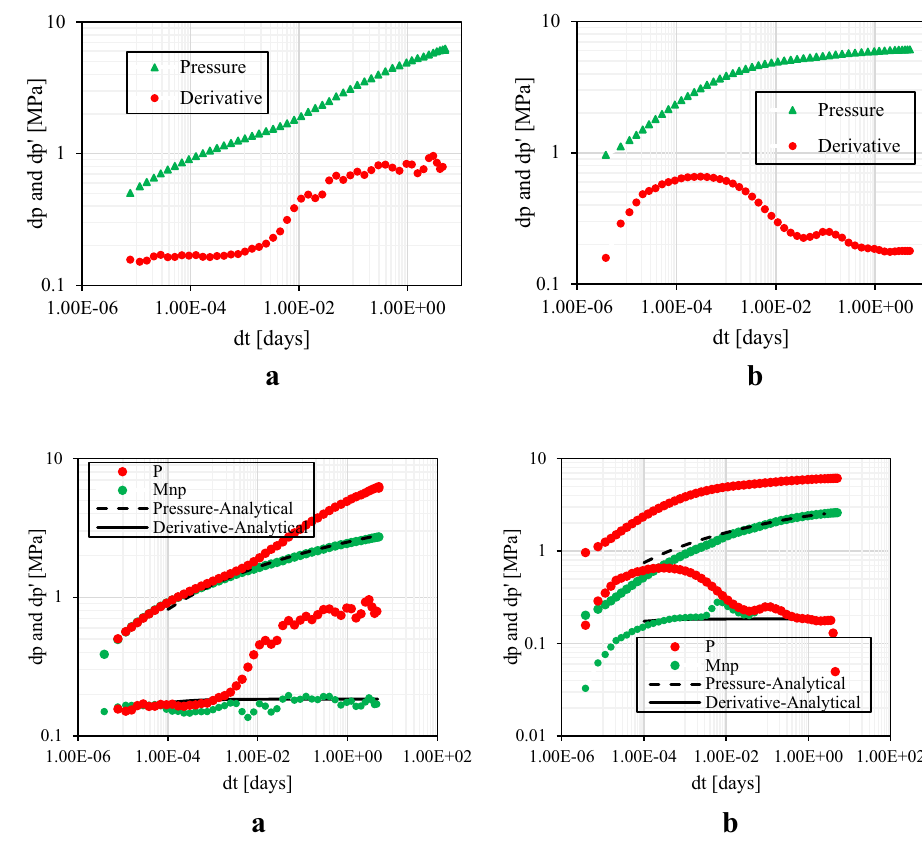
Fig. 8a with higher late time derivative stabilizations of Fig. 8b with higher early time derivative stabilizations of